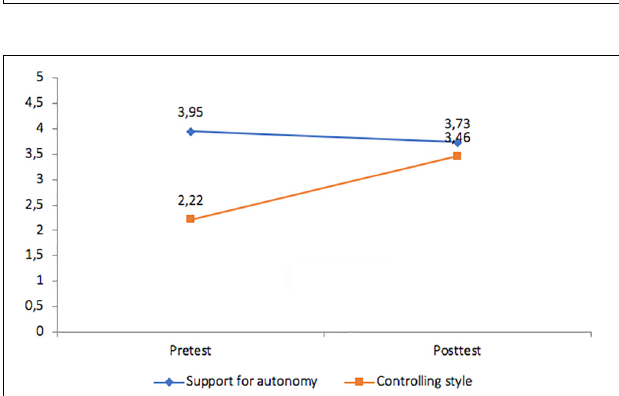
FIGURE 2 | Autonomy-supportive teaching style group: changes in student perceptions of instructional style.